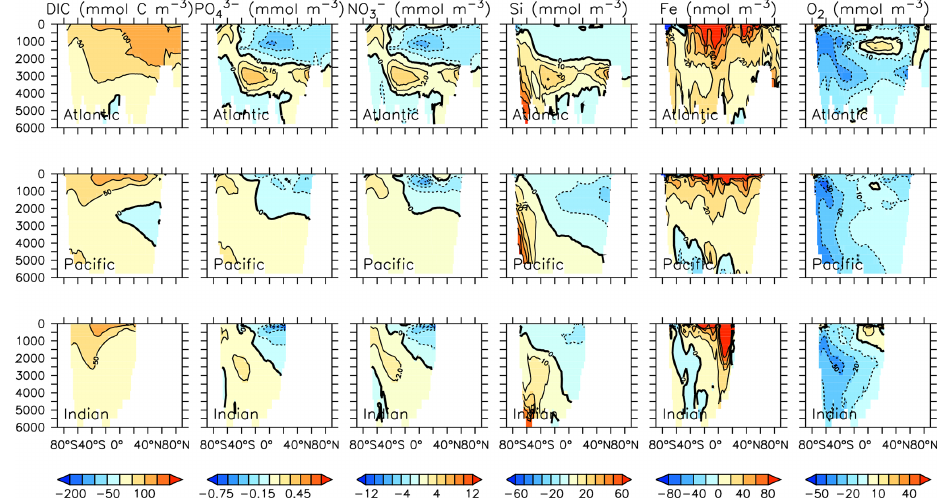
Figure 28. Modelled change in carbon and nutrient profiles by major ocean basins from 2014 to